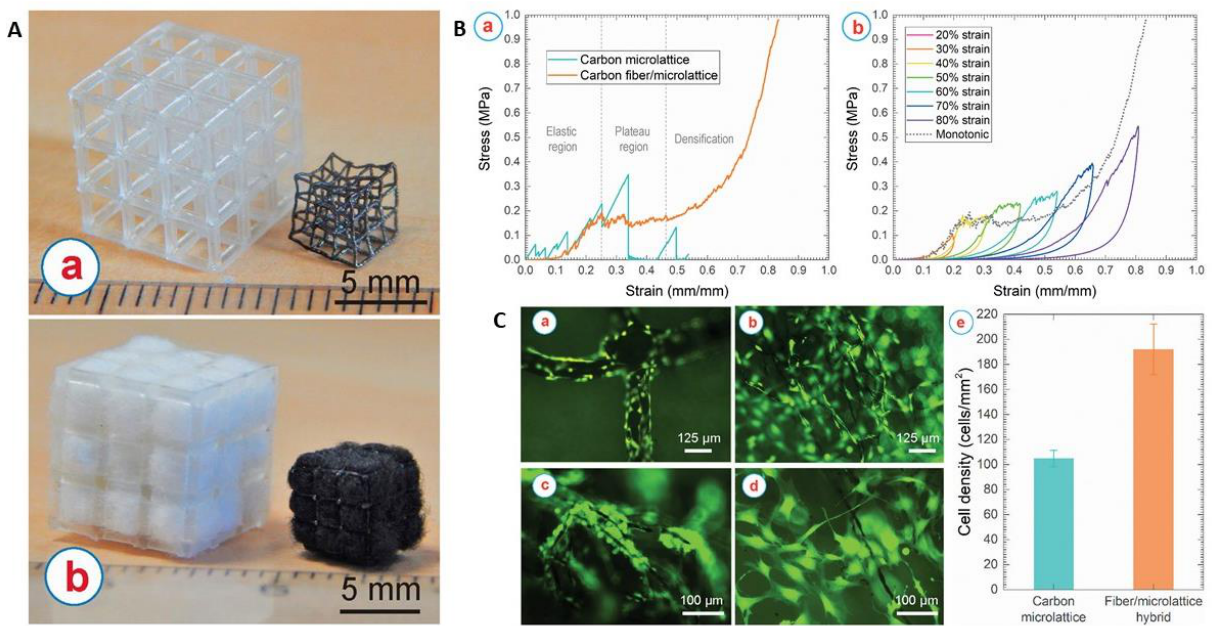
Figure 5. ( A ) ( a ) Additively manufactured microlattice architectures before (left) and after (right) carbonisation. ( b ) Cotton/microlattice hybrid architectures before (left) and after (right) carbonisation. ( B ) ( a ) Stress – strain curve of the carbon microlattice, and the carbon fiber/microlattice hybrid architecture. ( b ) Cycling loading of the carbon fiber/microlattice hybrid architecture with a sequential increment of strain. ( C ) Osteoblast-like murine MC3T3-E1 cells cultured on ( a ) carbon microlattice architectures and within ( b – d ) carbon fiber/microlattice hybrid architecture. ( c ) Proliferation of the cells along the carbon fibers and ( d ) shows the inter cellular network within the inner pores created by the carbon fibers. Some cells appear out of focus due to the presence of cells growing on different planes of the 3D scaffolds. ( e ) Comparison of the density of the cells colonised on the carbon microlattice architecture and within the carbon fiber/microlattice hybrid architecture. Reproduced with permission from Ref. [125]; copyright (2021), Elsevier.